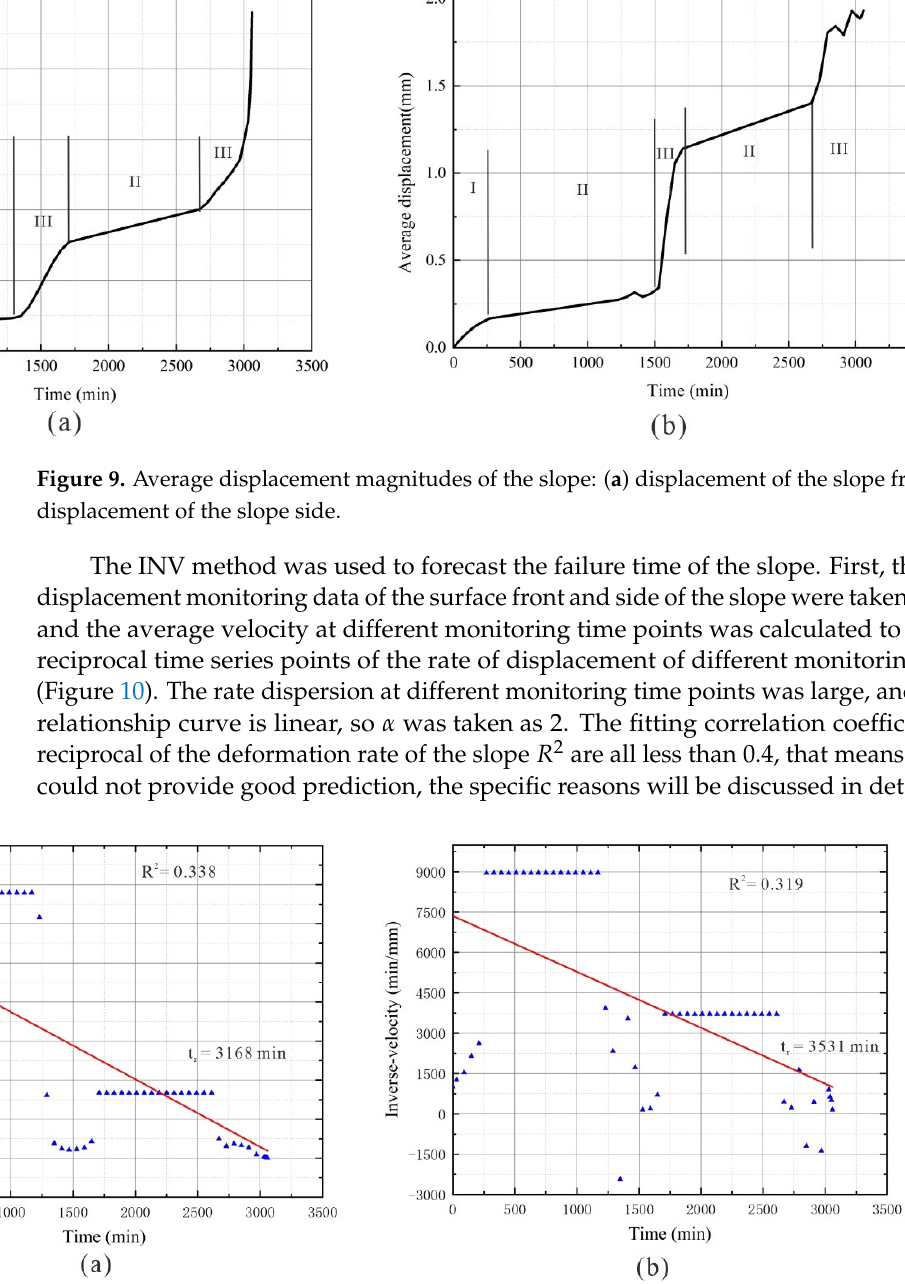
Figure 8. Displacement magnitudes of the slope at di ff erent depths (60 cm, 80 cm, 100 cm, 120 cm, 140 cm, corresponding to the vertical distance from the top of the slope): ( a ) displacement of the slope front; and ( b ) displacement of the slope side.